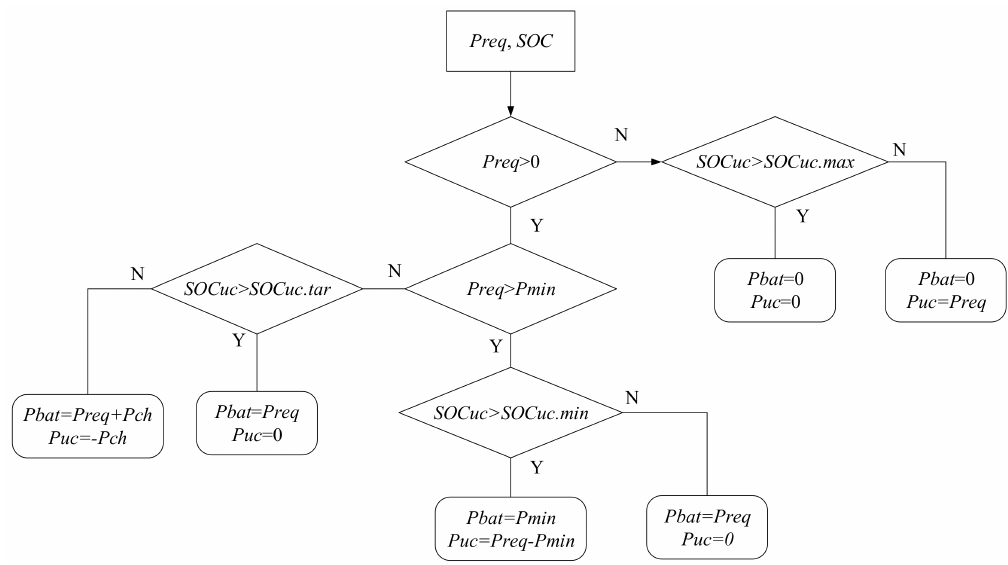
Figure 2. Diagram of the rule-based